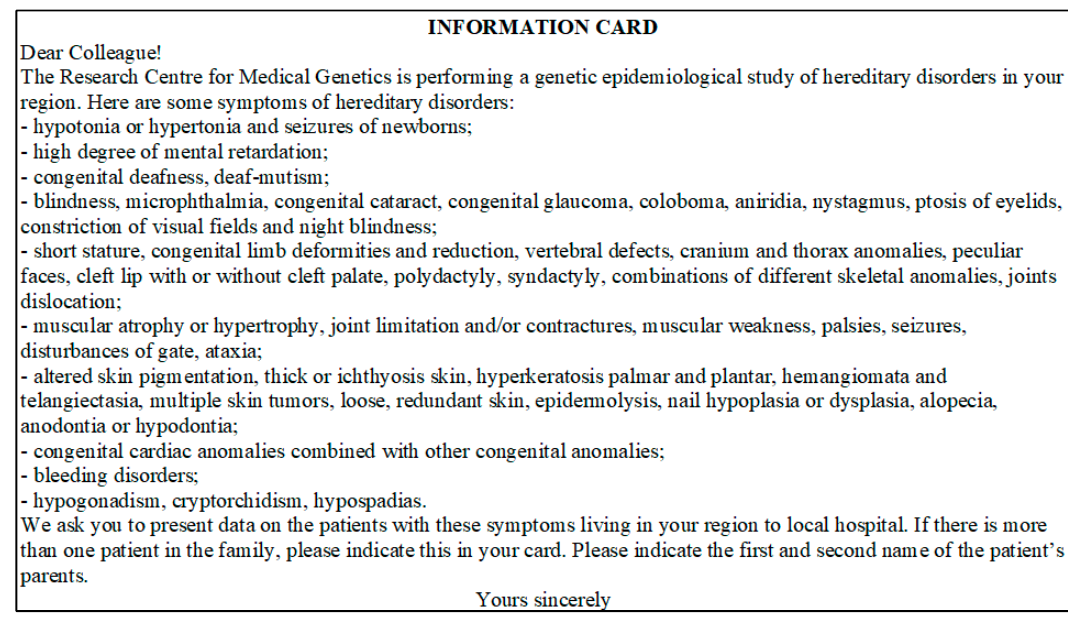
Figure 2. Information card–questionnaire.